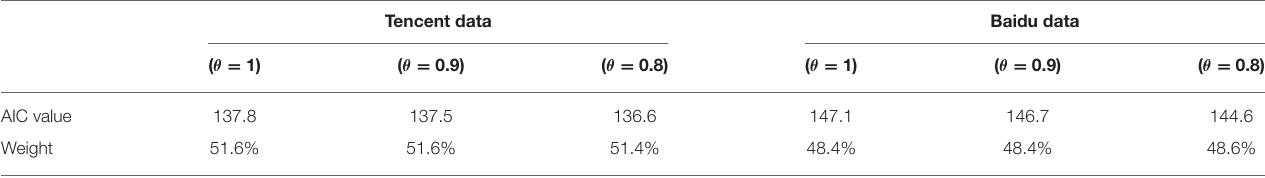
TABLE 1 | AIC value and calculated Weight of final estimate for different sources of population data (under different assumptions of, θ , probability of an unspecified case reported in other cities/regions being an exported case from Wuhan).